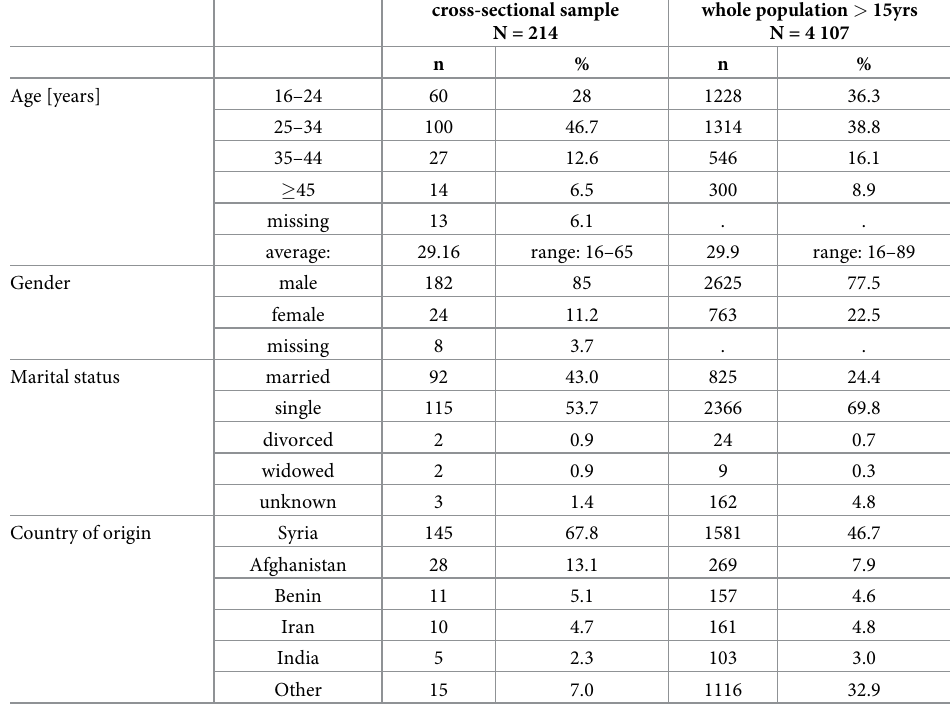
Table 1. Demographic characteristics of the cross-sectional sample and the whole cohort of asylum seekers in 2015 in Halle (Saale),